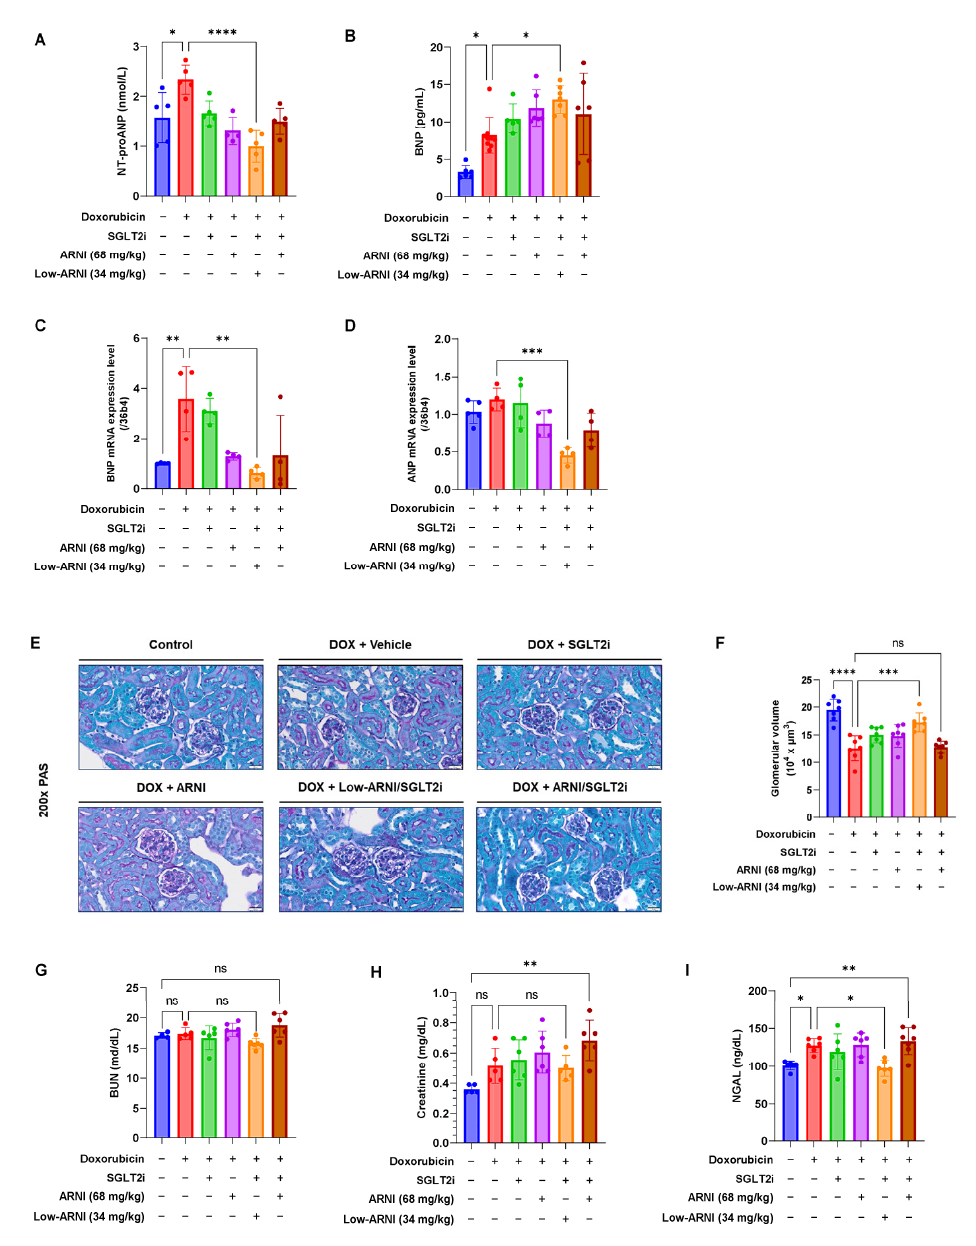
Figure 4. Effects of ARNI and SGLT2i treatment on heart-driven hormones in chronic doxorubicin- injected mice. ( A ) Plasma concentration of NT-proANP and ( B ) BNP 9 weeks after doxorubicin treatment initiation ( n = 5–6/group). ( C ) mRNA expression of BNP and ( D ) ANP ( n = 4–5/group). ( E ) Representative PAS staining of kidney cross-sections. ( F ) Quantitative mean glomerular volume ( n = 6–7/group). ( G ) Plasma concentrations of BUN, ( H ) creatinine, and ( I ) NGAL 9 weeks after doxorubicin injection ( n = 4–6/group). ns, no significance, * p < 0.05, ** p < 0.01, *** p < 0.001, **** p < 0.0001 .